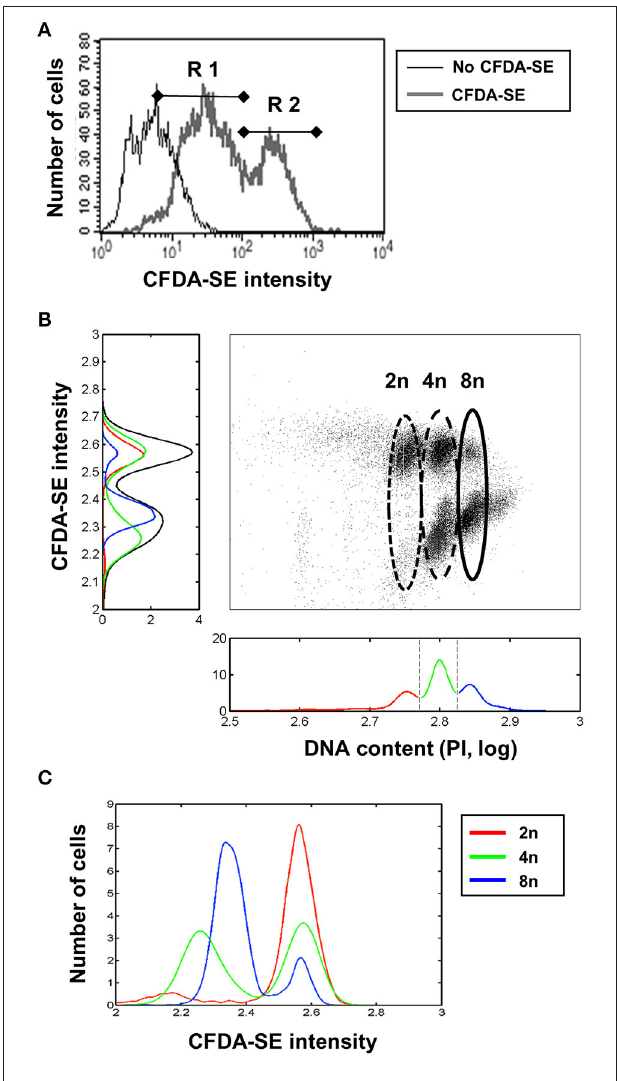
FIGURE 3 | Higher substrate-induced metabolism in hepatocytes with diploid nuclei. (A) Two types of hepatocytes differing in their levels of CFDA-SE metabolism directly after isolation, as detected by flow cytometry. (B) 2n cells convert more CFDA-SE than 8n. Two different populations could be observed in cells containing intermediate amounts of DNA (4n). (C) Normalized CFDA-SE intensities in 2n, 4n, and 8n populations shown separately. The 4n cells could be separated into two different populations, probably dependent on the number of nuclei per cell (2*2n or